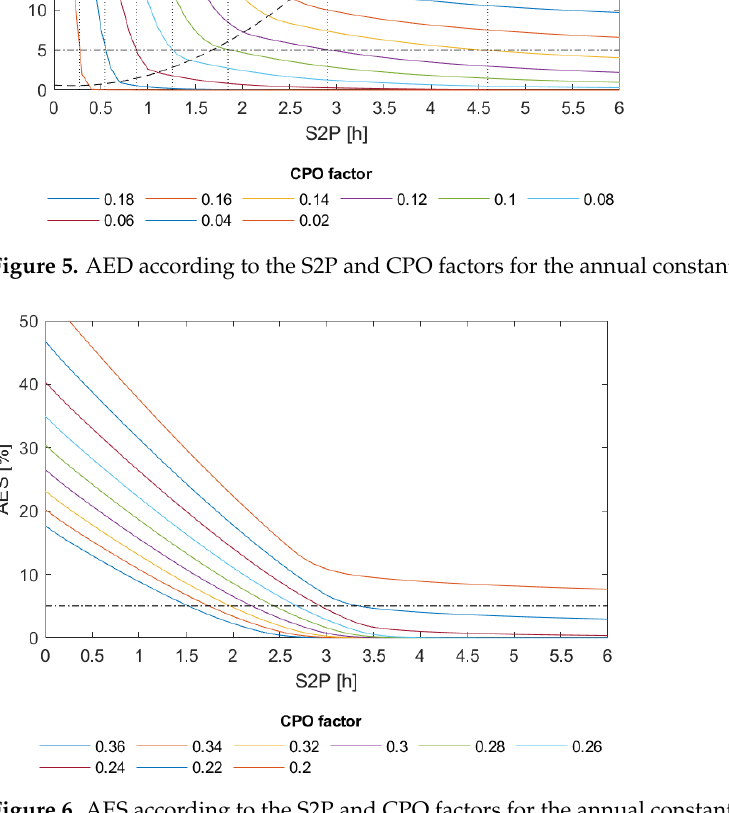
Figure 6. AES according to the S2P and CPO factors for the annual constant power setpoint (ACPS).